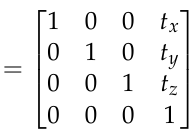
Figure 7. The major synthesis process for prior synthetic datasets based on a prior series data.